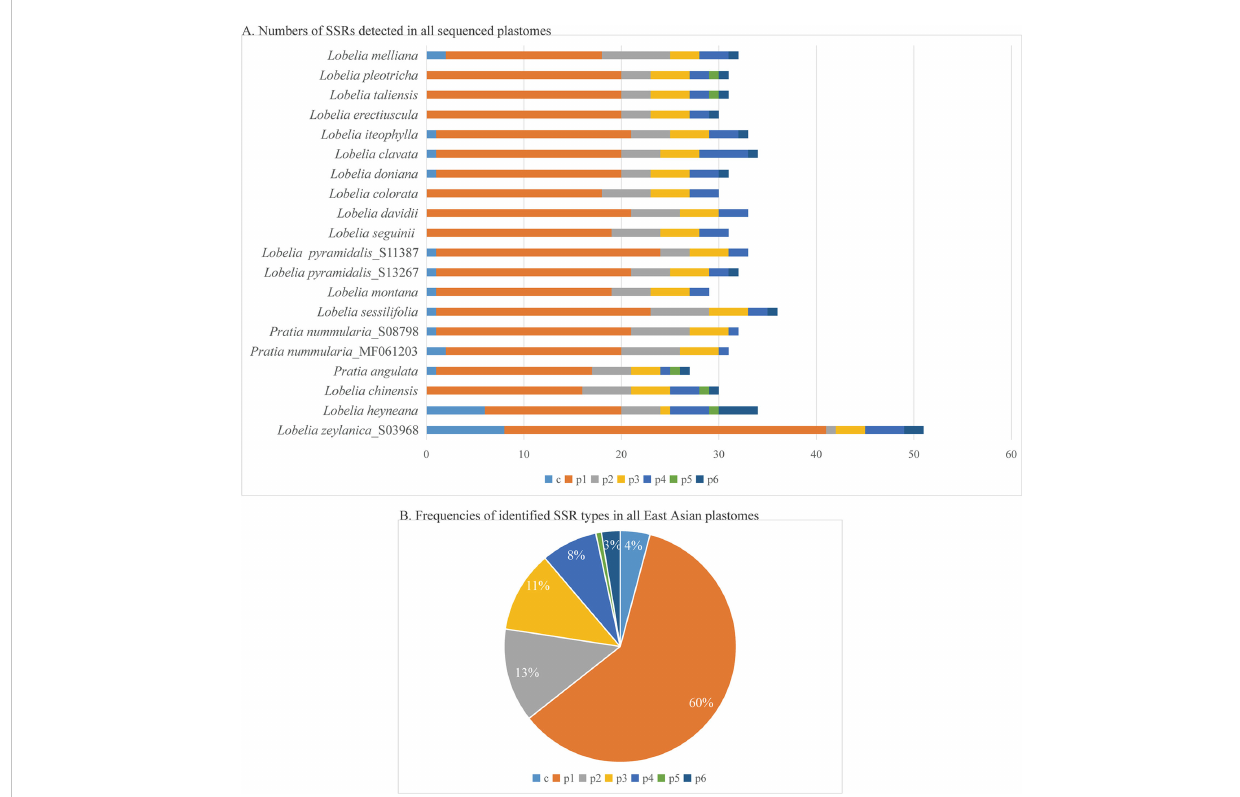
FIGURE 4 Comparison of simple sequence repeats (SSRs) among Asian plastomes. (A) Numbers of SSRs detected in all sequenced plastomes. (B) Frequencies of identi fi ed SSR types in all plastomes of East Asian species. p1, mononucleotides (mono-); p2, dinucleotides (di-); p3, trinucleotides (tri-); p4, tetranucleotides (tetra-); p5, pentanucleotides (penta-); p6, hexanucleotides (hex-); c, compound.